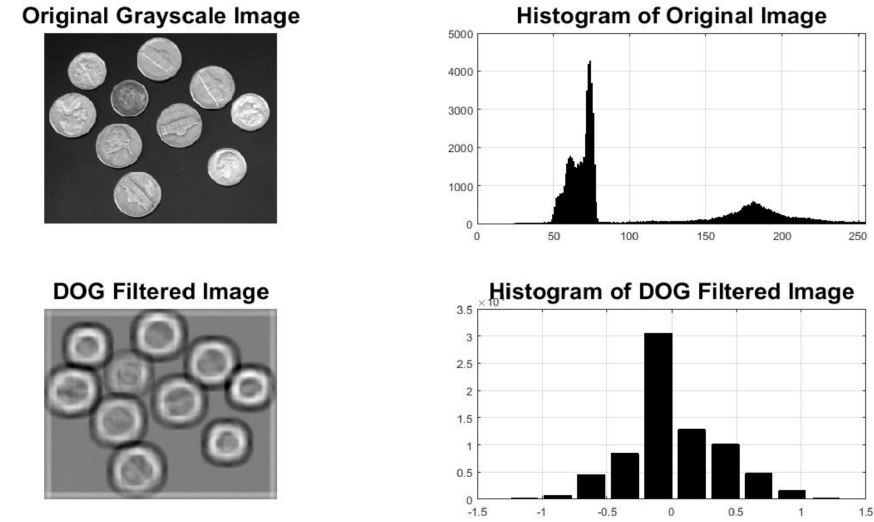
Figure 2. Visual explanation of the difference of Gaussian (DoG)